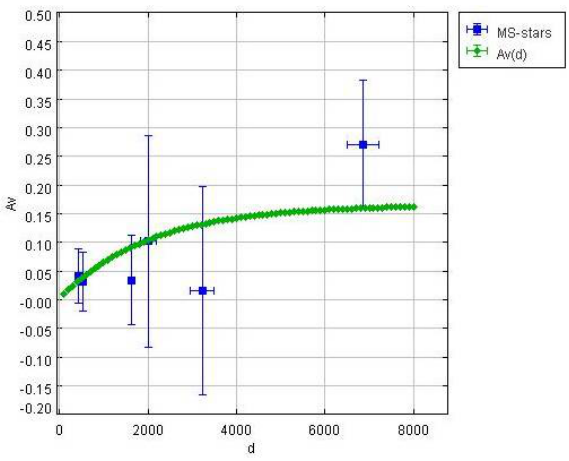
Fig. 1. A V ( d ) relation for area